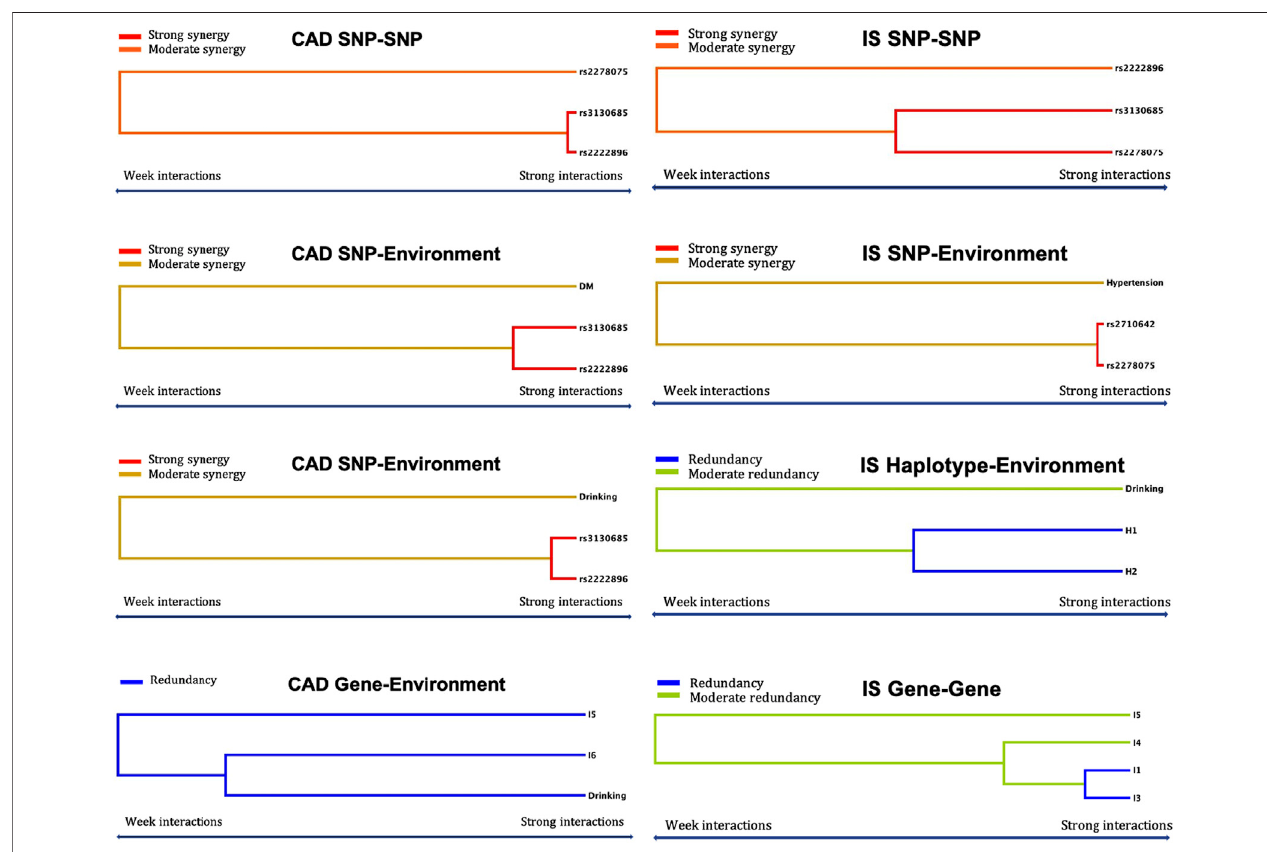
FIGURE 4 | Optimal interactions affecting diseases shown in a dendrogram. Elements that interact strongly with each other appear close together in the leaves of the tree, while elements that interact weakly appear far from each other. The yellow, orange and red colors indicate synergy effect between two factors, and blue and green colors indicate redundancy effect between two factors. The darker the color, the stronger the